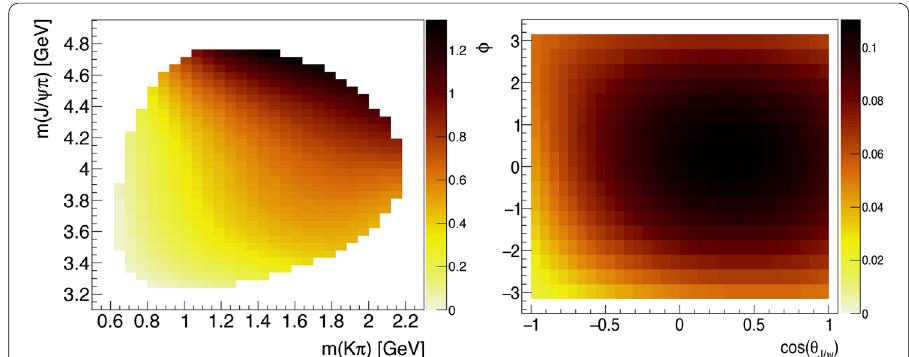
Fig. 10 Simulated background template for the scatter plots of the two mass variables (left) and the two angular variables (right) of the decay. In the former, the 2D kinematic boundary reflects the decay kinematics. The z -axis values are arbitrary